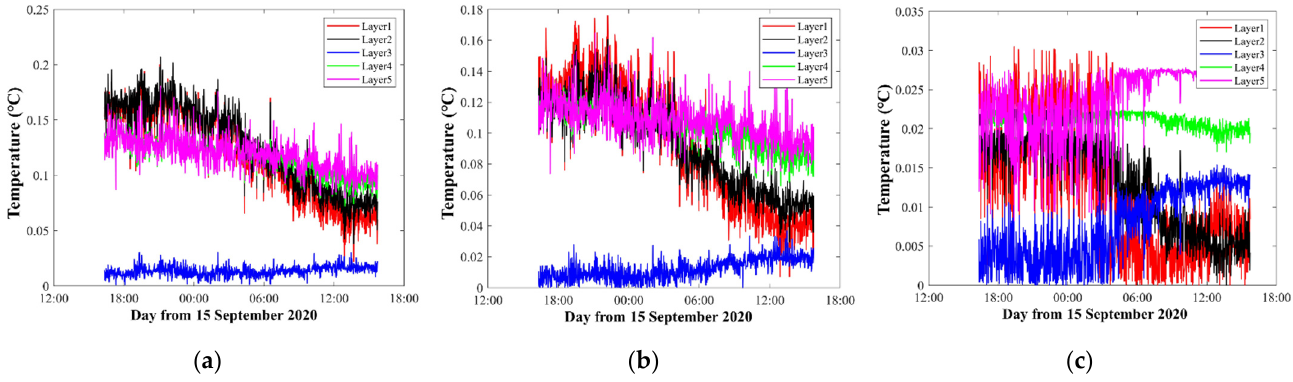
Figure 14. Temperature inversion errors. The red, black, blue, green and purple curves indicate the errors of the first layer, the second layer, the third layer, the fourth layer, and the fifth layer, respectively. ( a – c ) correspond to the results of Figure 12a – c, respectively.